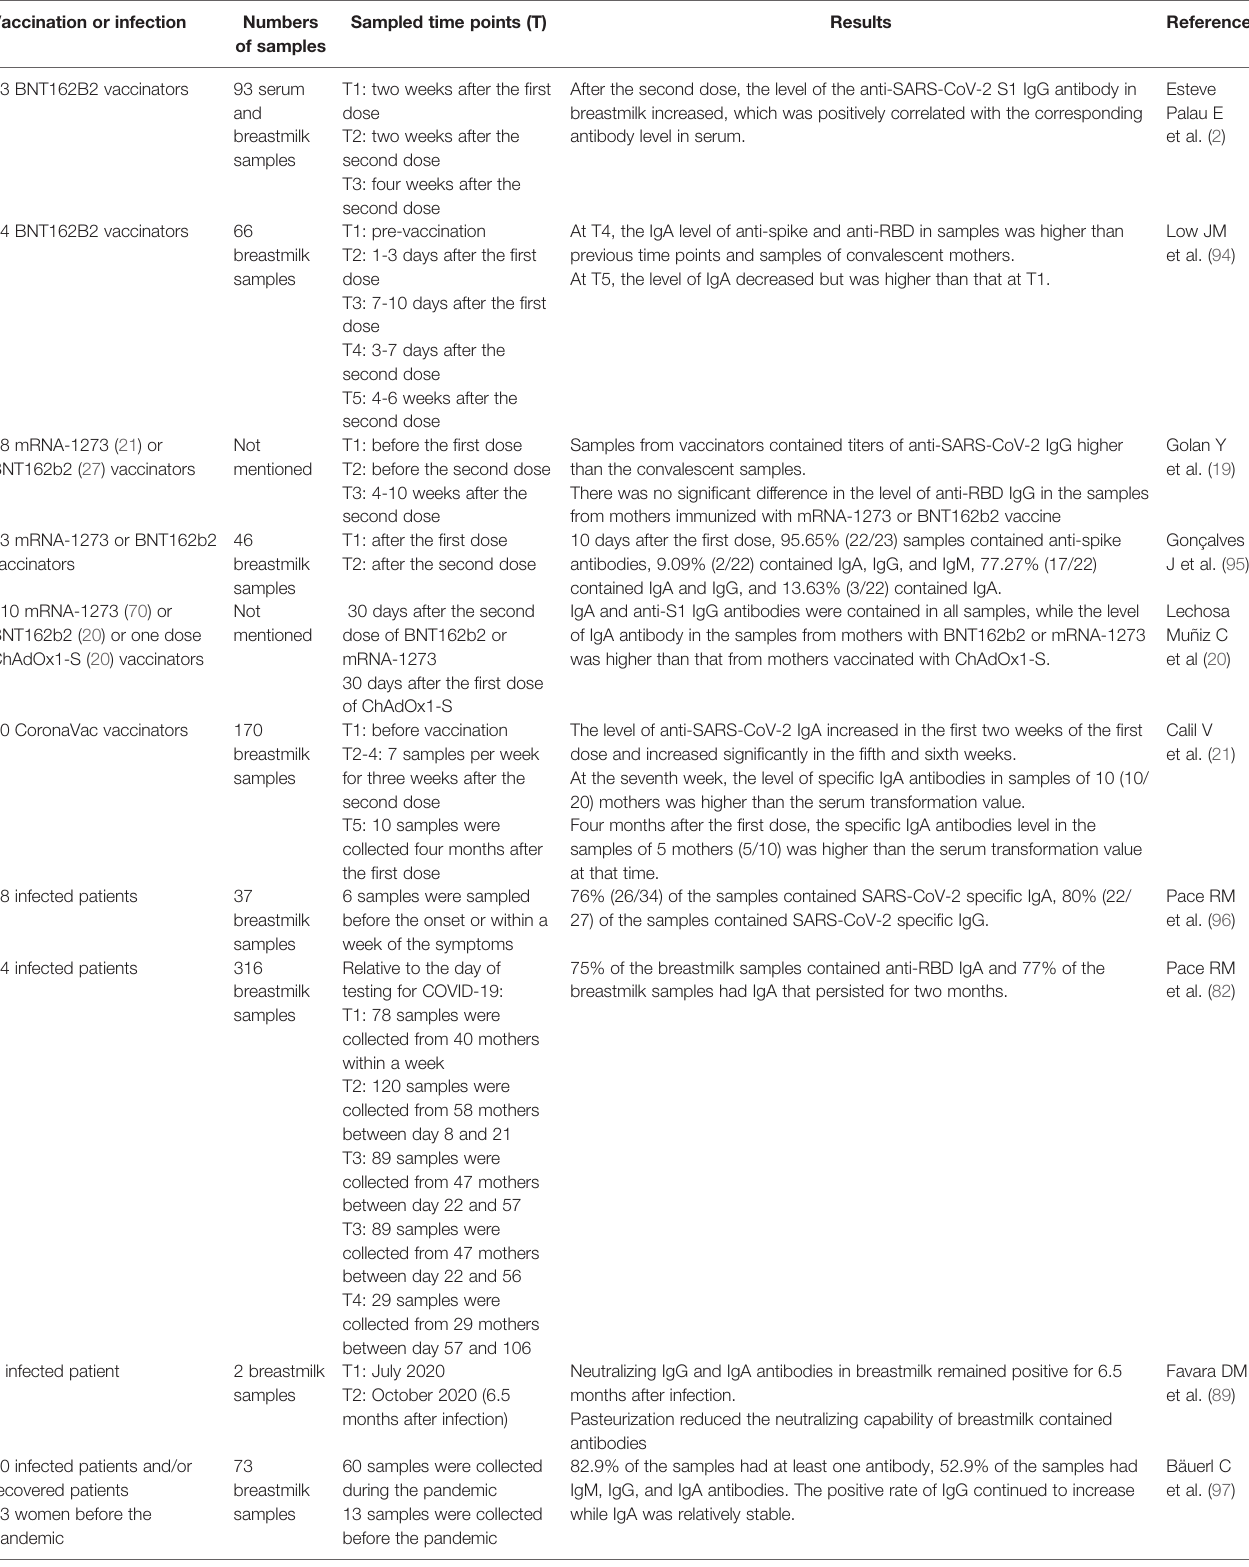
TABLE 1 | Speci fi c antibodies to the SARS-CoV-2 exist in the human milk. Vaccination or